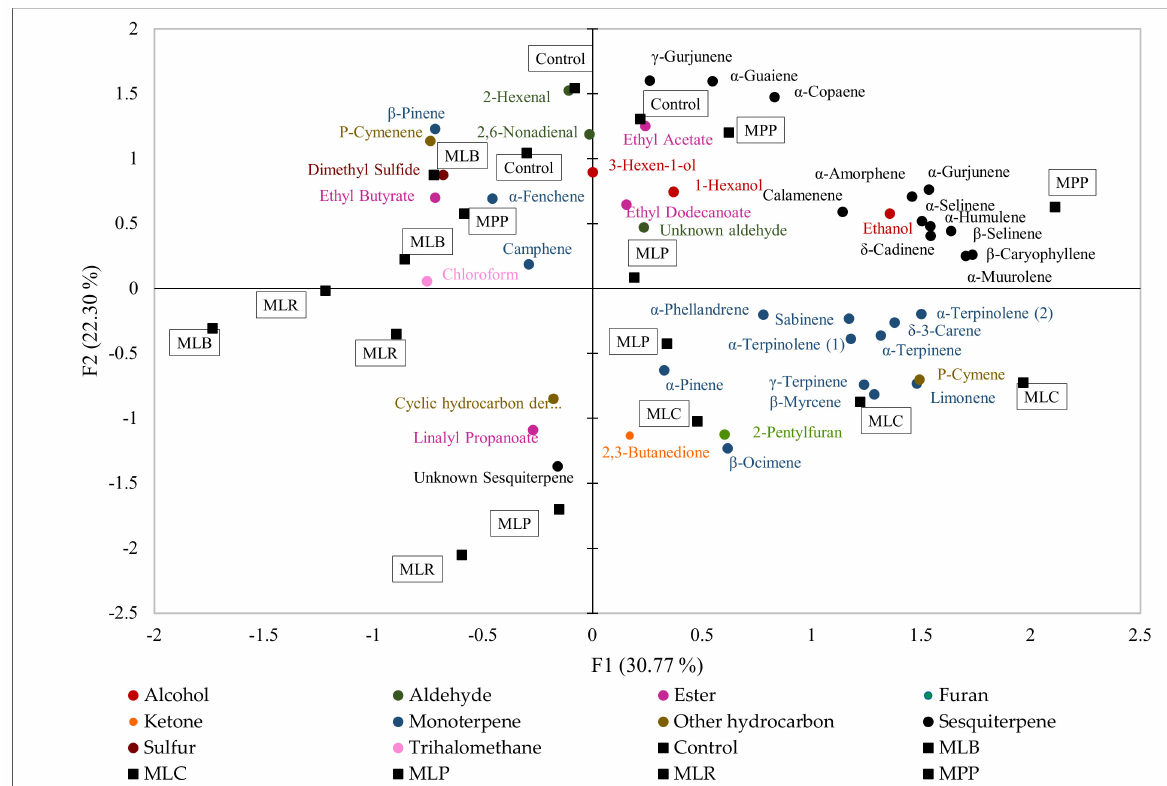
Figure 2. Principal component analysis (PCA). Biplot based on values of volatile compounds (ng/mL of 2-octanal equivalents) in mango juice. Mango juices fermented with MLB— Levilactobacillus brevis ; MLC— Lacticaseibacillus casei ; MLP— Lactiplantibacillus plantarum subsp. plantarum ; MLR— Lacticaseibacillus rhamnosus ; MPP— Pediococcus pentosaceus . Control is mango juice with no lactic acid bacteria under the same conditions of fermentation (24